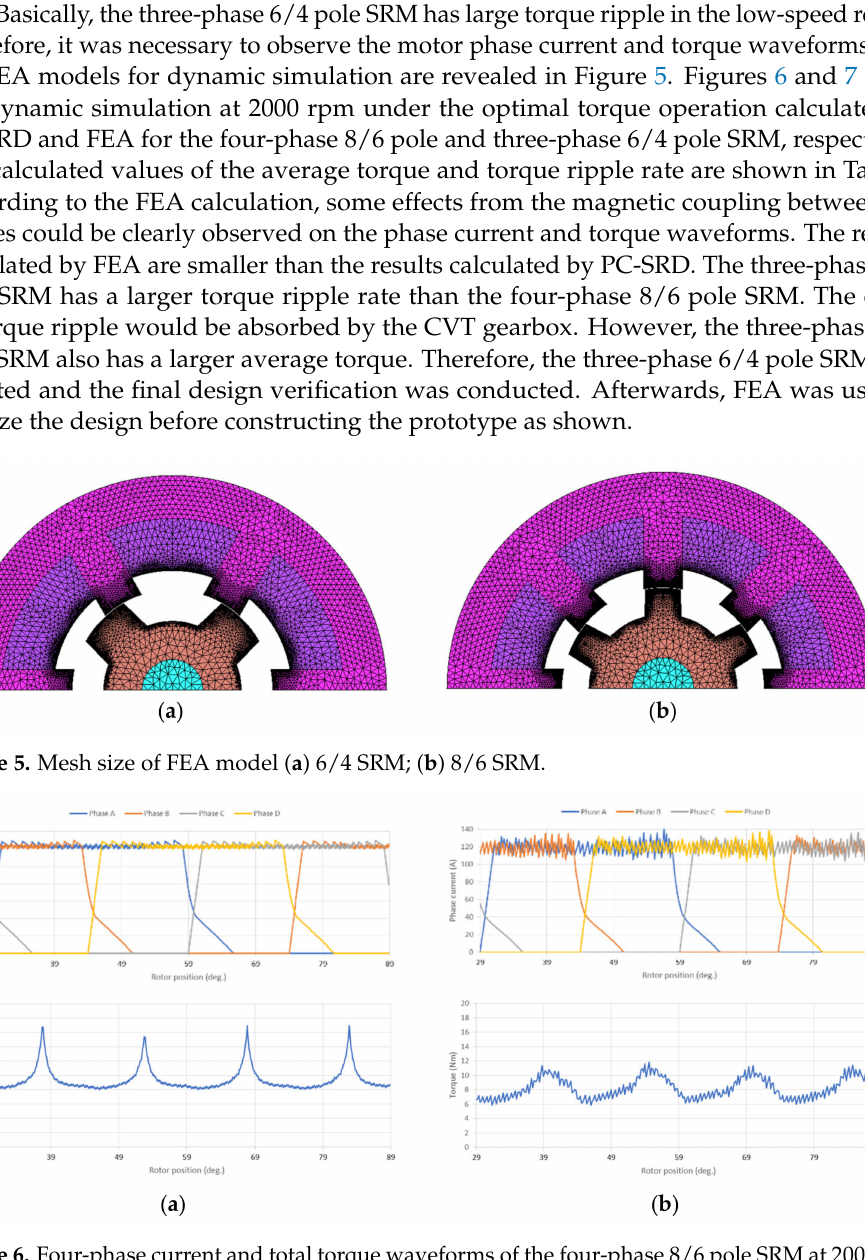
Figure 6. Four-phase current and total torque waveforms of the four-phase 8/6 pole SRM at 2000 rpm calculated from ( a ) PC-SRD; ( b )